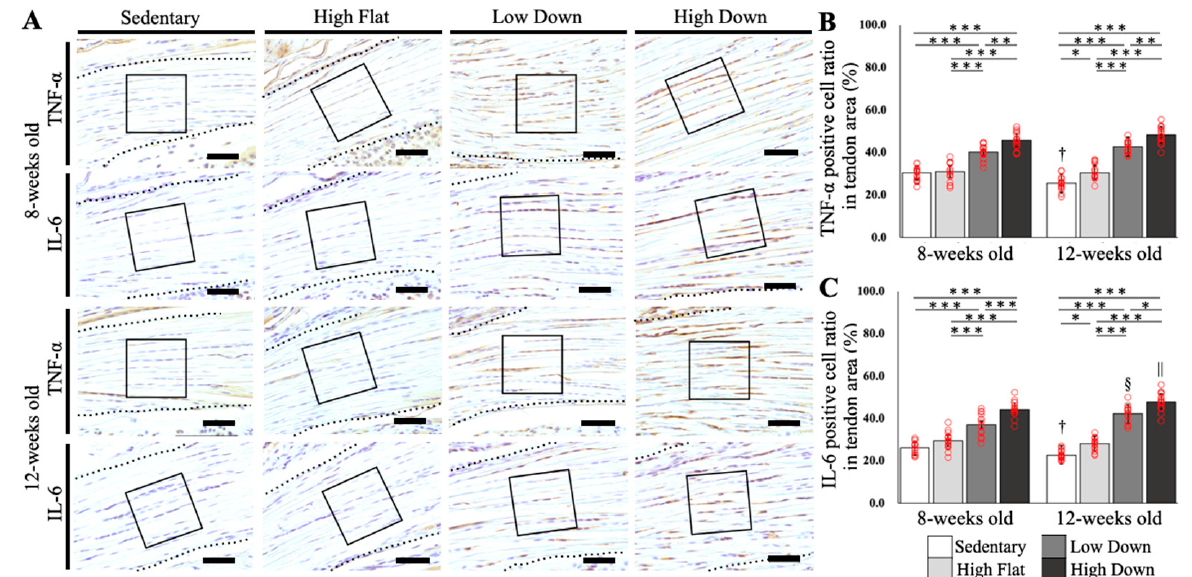
Figure 6. Comparison results of TNF- α and IL-6 expression in the tendon area. ( A ) IHC-stained tissue images of the tendon areas according to week age. TNF- α and IL-6 are used as primary antibodies. The black dot line indicates the tendon. The black box indicates the analysis area. ( B ) Comparison results of TNF- α expression in the tendon area. ( C ) Comparison results of IL-6 expression in the tendon area. Statistical significance: * p < 0.05, ** p < 0.01, *** p < 0.001. † p < 0.05 (8-week-old, Sedentary group vs. 12-week-old, Sedentary group), § p < 0.05 (8-week-old, Low Down group vs. 12-week-old, Low Down group), || p < 0.05 (8-week-old, High Down group vs. 12-week-old, High Down group). TNF, tumor necrosis factor; IL, interleukin; IHC, immunohistochemical. Scale bar: 50 µm.